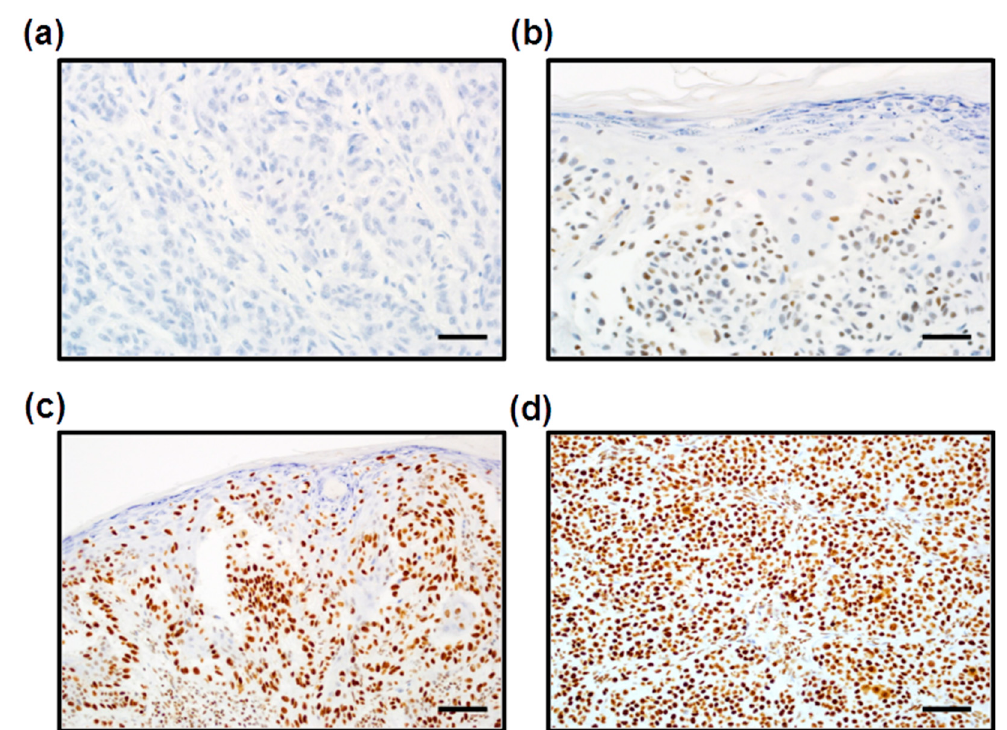
Figure 3. Immunohistochemical analysis of PARP1 expression in cutaneous melanoma patients. Lack of PARP1 immunoreactivity in melanoma cells (( a ), 400×). Low nuclear expression of PARP1 in melanoma cells (( b ), 400×). High PARP1 expression localized in the nuclei of melanoma cells (( c ), 200×; ( d ), 200×). Scale bars for 200× and 400× are 200 μ m and 100 μ m, respectively. Table 4. Correlations between PARP1 expression and clinical parameters of cutaneous melanoma patients without lymph node metastases.